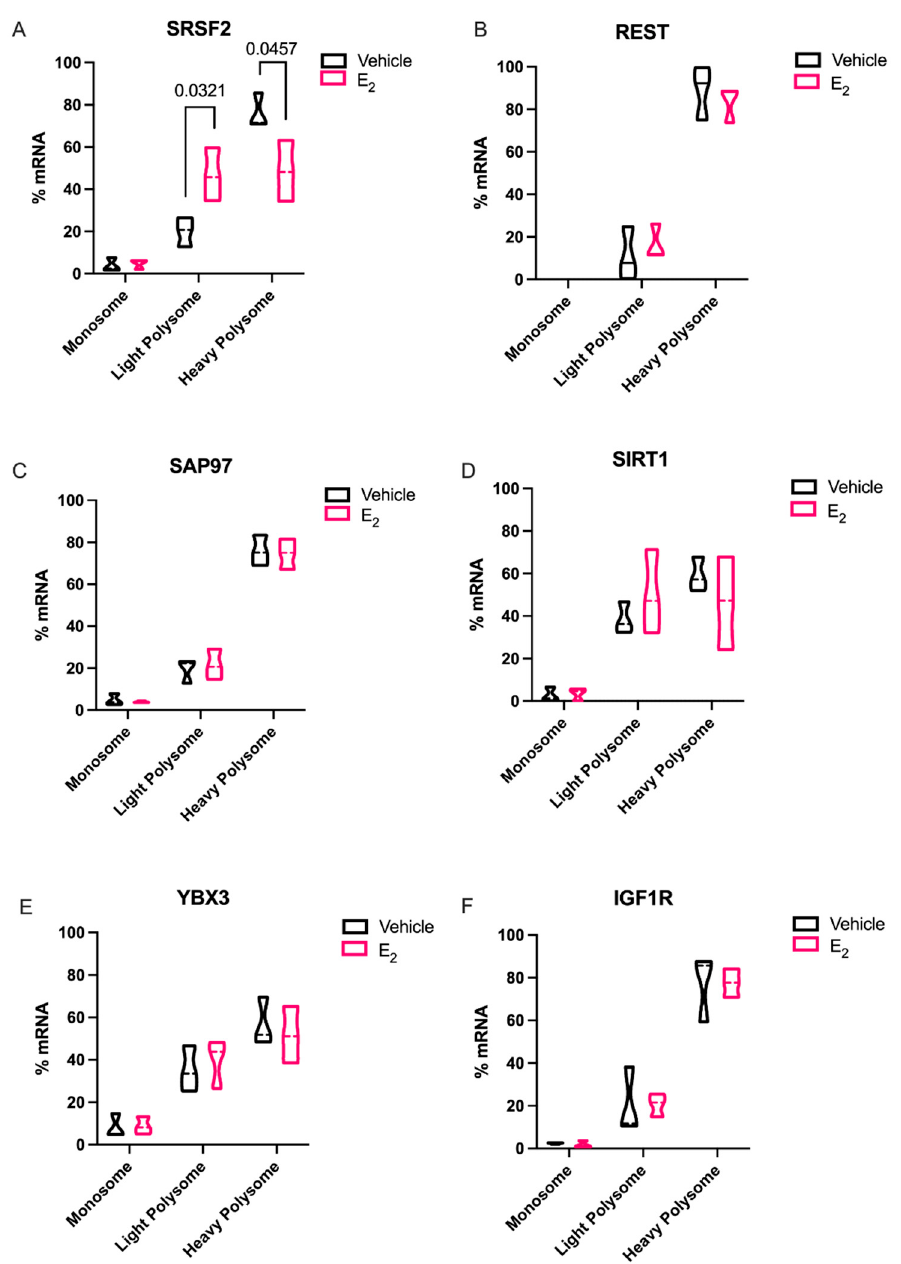
Figure 7. Effects of E 2 treatment on miR-9-5p and miR-9-3p mRNA gene targets in polysome fractions in hypothalamic-derived neuronal cells. Cells were treated with E 2 for 15 h and fractionated using sucrose gradient density sedimentation. Total RNA was isolated from pooled from the monosome (fractions 1–4), light polysome (fractions 5–7), and heavy polysome (fractions 8–10) fractions. mRNA expression levels were analyzed as fold change from vehicle treatment using ∆∆ Ct method. Data are represented as mean % total mRNA ± SEM (N = 3 independent experiments). Significance was noted when p < 0.05.